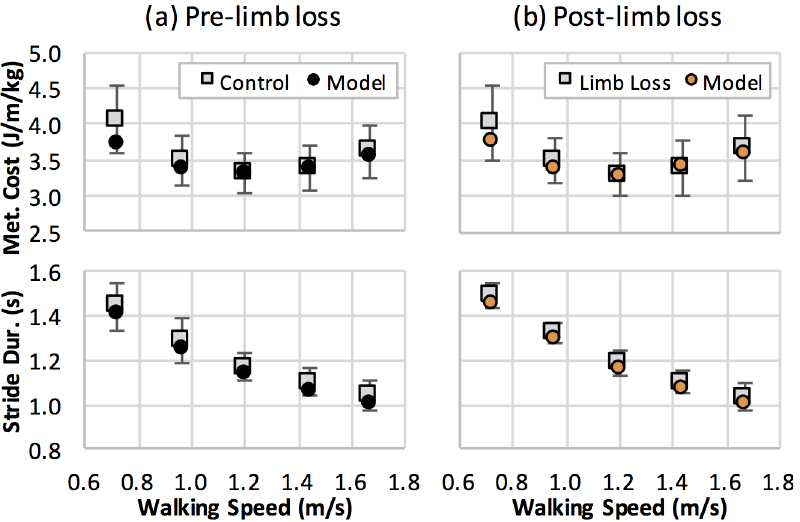
Fig 3. Model validity. Metabolic cost and stride duration for simulations of walking at five different speeds (circles) using (a) the pre-limb loss model and (b) the post-limb loss model. The squares and error bars are means and standard deviations for human experimental data [10] with (a) Service Members with two intact limbs and (b) Service Members with unilateral transtibial limb loss walking with a passive transtibial prosthesis.